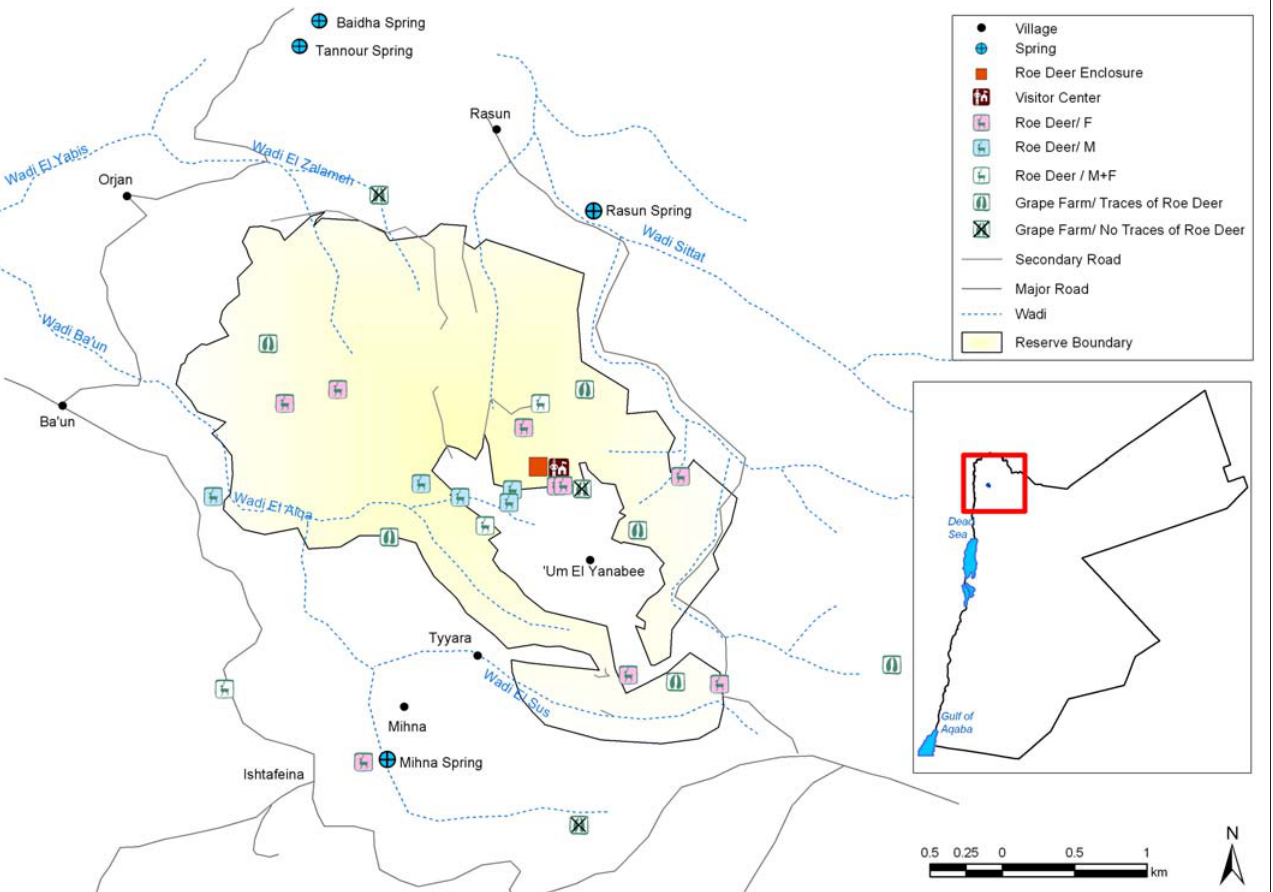
Figure 1. Distribution of the European Roe Deer Capreolus capreolus population at Ajloun Nature Reserve, Jordan, in